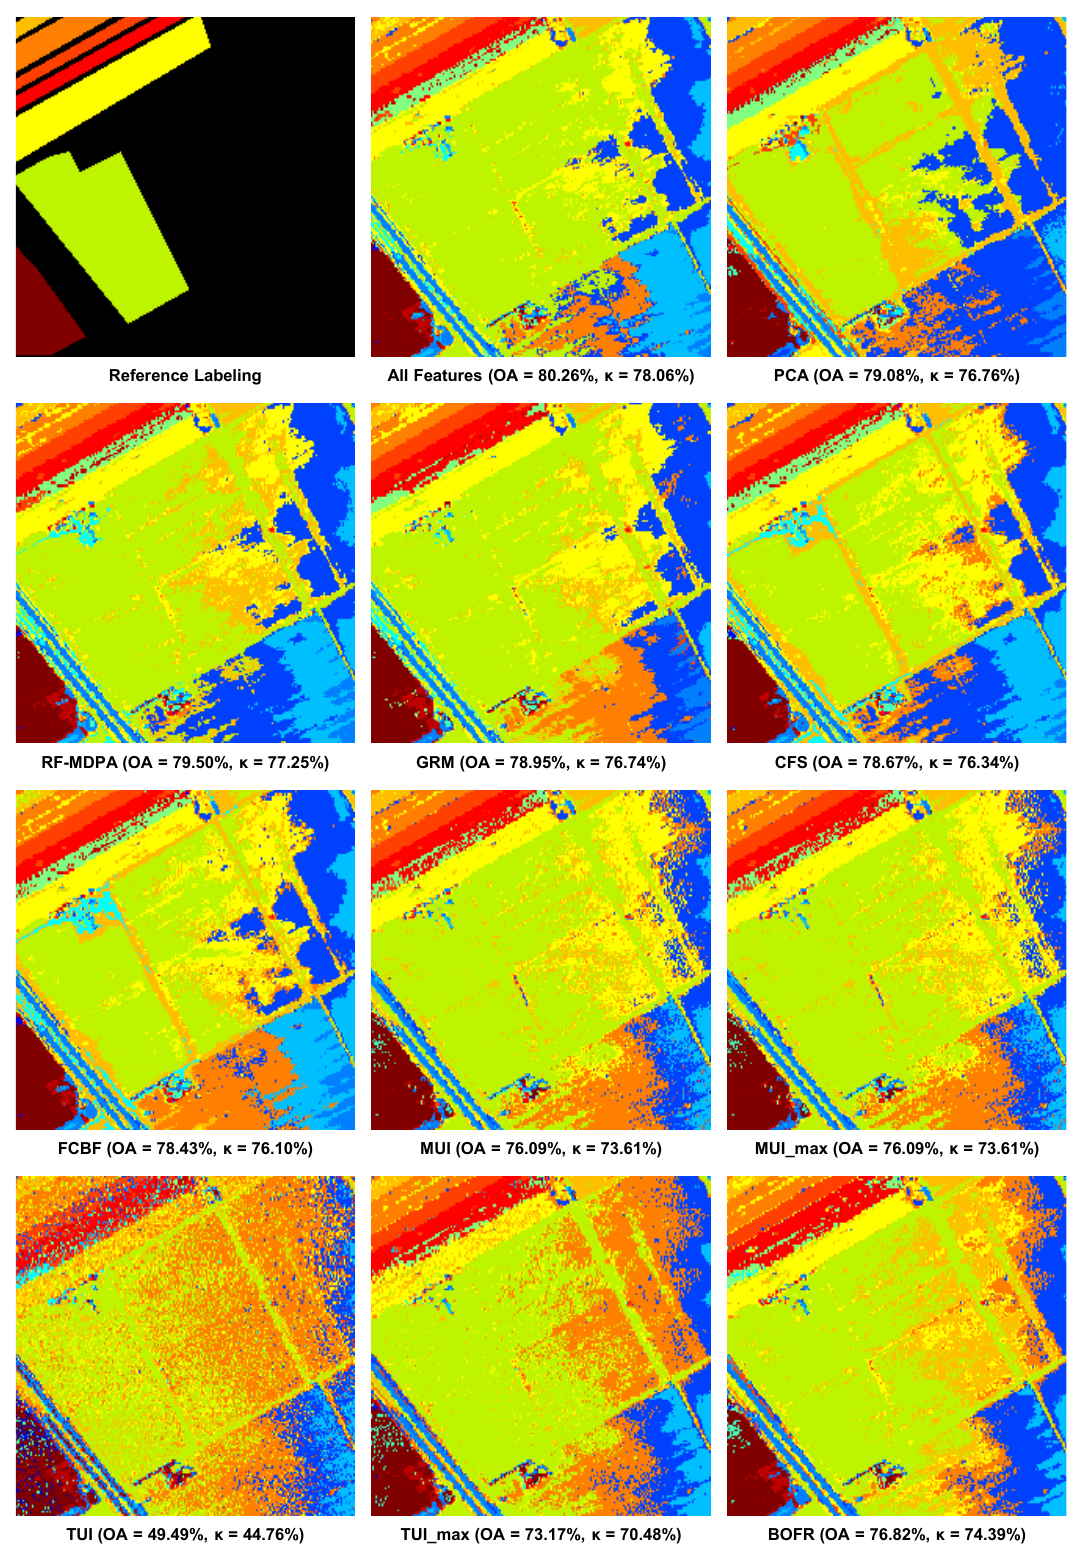
Figure 14. Part of the classified scene for the Salinas dataset when using the RF classifier and different feature sets. The values in brackets refer to the evaluation on the test